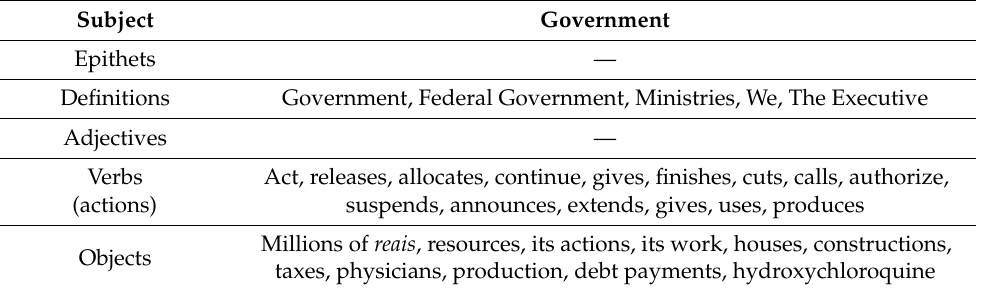
Table 14. The Government.